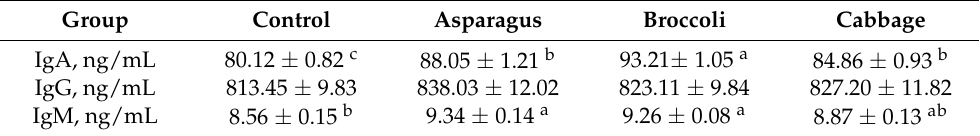
Table 2. Effects of vegetable powder on serum immunoglobulin concentrations of mice.